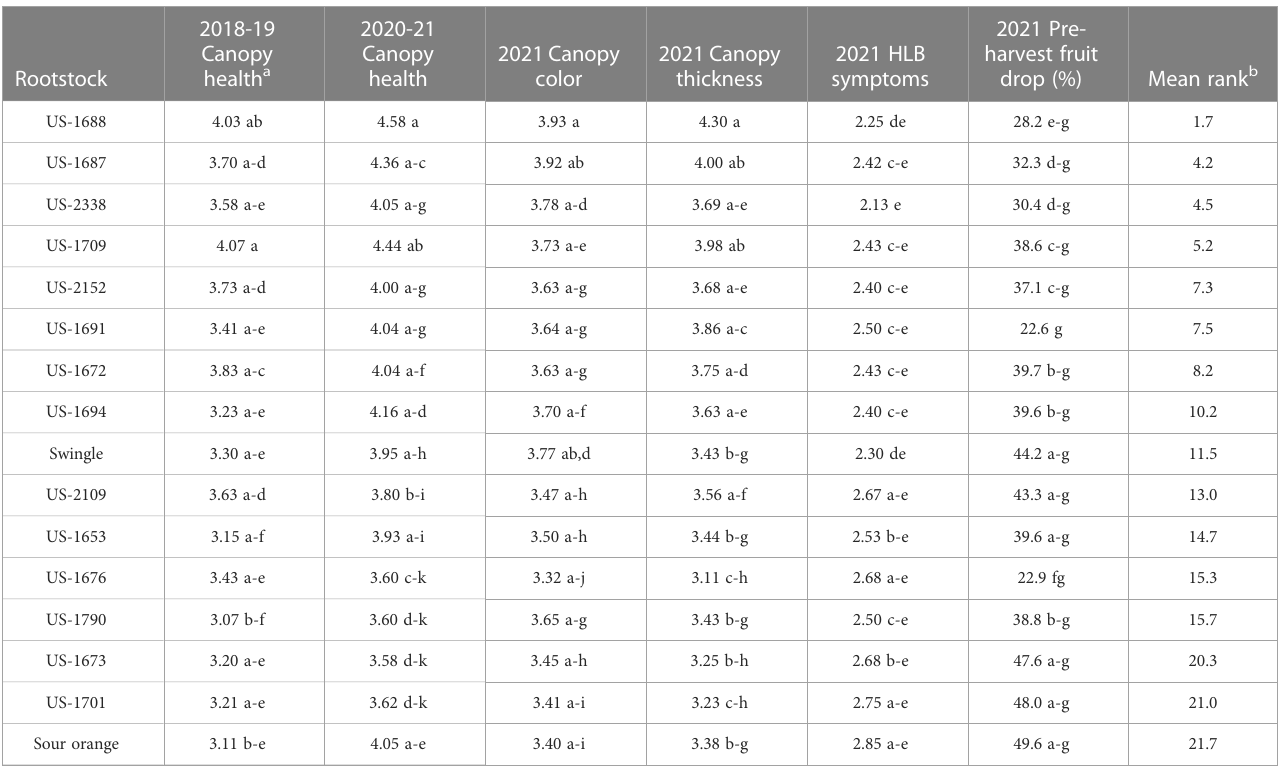
TABLE 5 Canopy health and HLB